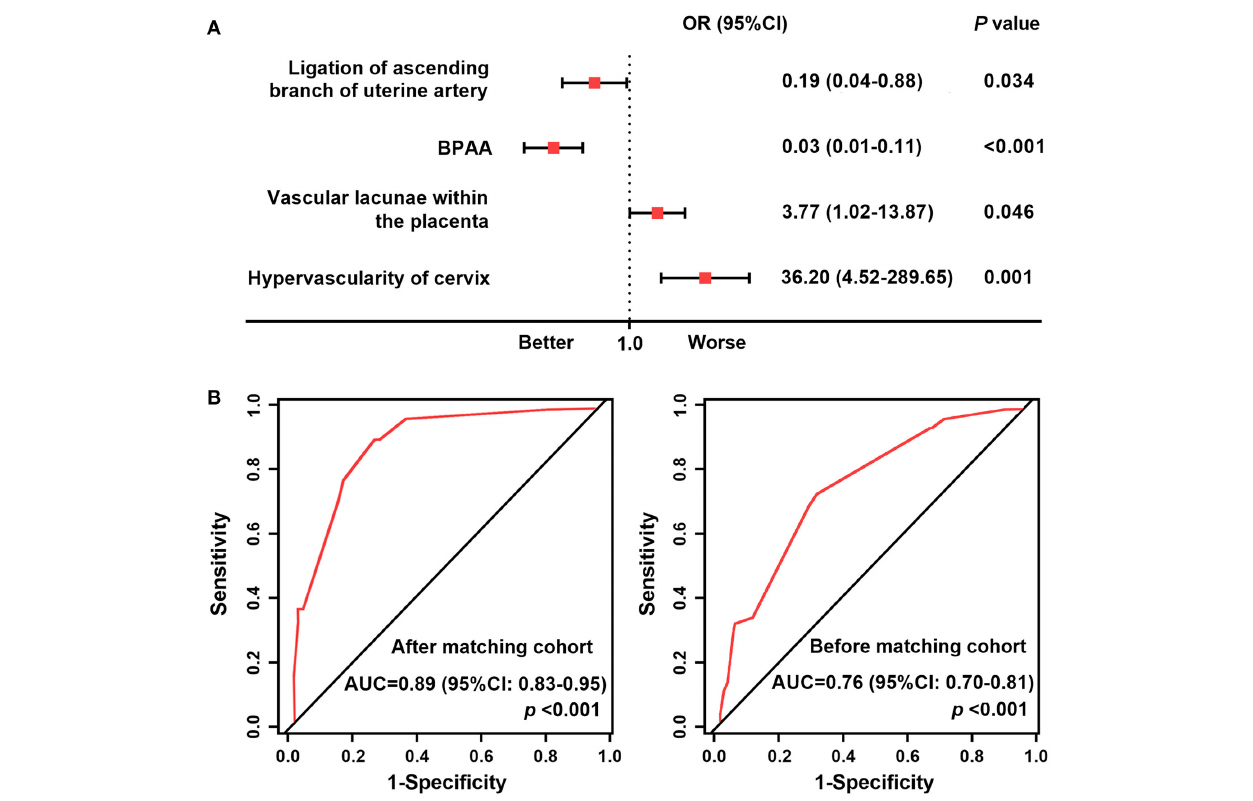
FIGURE 4 | Forest plot and receiver operating characteristic curves. (A) Forest plot showing the result of multivariate logistic regression analysis of factors associated with a high risk of adverse maternal outcomes in the post-matched cohort. (B) ROC curves of the high-risk factors. AUC, area under the receiver operating characteristic curve; BPAA, balloon placement in the abdominal aorta; ROC, receiver operating